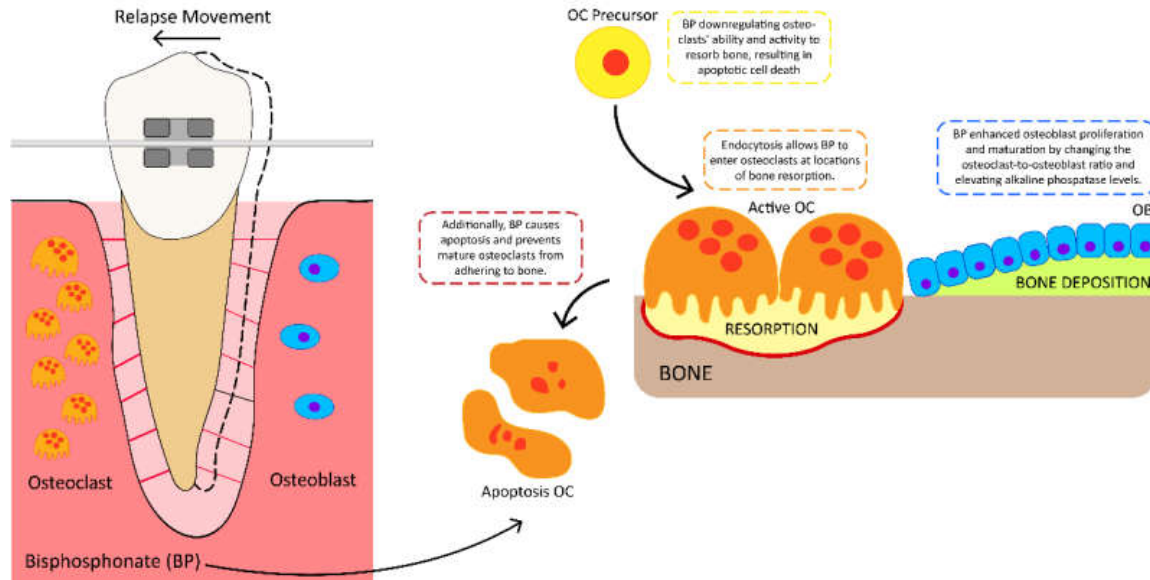
Figure 4. The mechanism of action of bisphosphonate (BP) in the prevention of orthodontic relapse. BP can enter the osteoclasts at sites of bone resorption via endocytosis. BP inhibits the capability and activity of osteoclasts, which causes apoptotic cell death. BP also restricts mature osteoclasts from attaching to bone. By altering the osteoclast-to-osteoblast ratio and raising alkaline phosphatase levels, BP promotes osteoblast proliferation and maturation. BP: bisphosphonates; OC: osteoclast; OB: osteoblast.